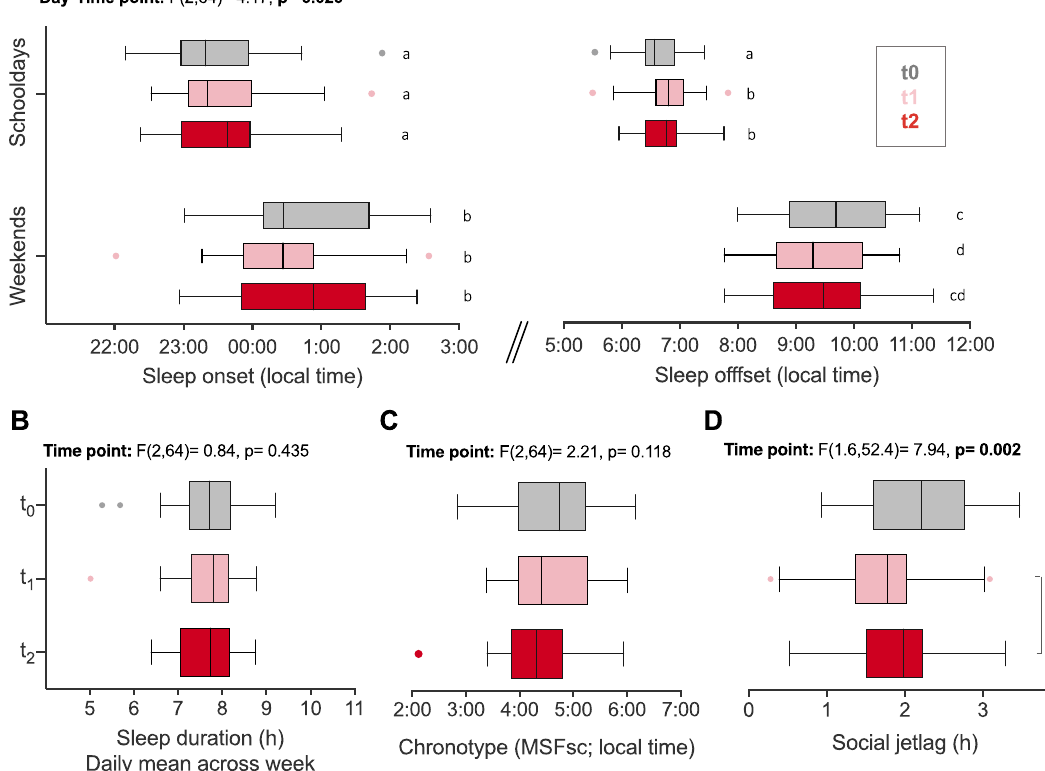
Figure 6. Comparison of sleep parameters across school start systems. Sleep parameters from the longitudinal cohort (n = 33) comparing the conventional start system at baseline (t0, grey) with the flexible system during t1 (light red) and t2 (dark red). ( A ) Average sleep onset and offset on schooldays and weekends. Results of two-way repeated measures ANOVAs with the factors day (schooldays/weekends) and time point (t0/t1/t2) are provided. Given the significant interaction effect, main effects are not reported. Letters indicate results of post-hoc tests on simple contrasts, with data marked by different letters demonstrating significant differences. ( B ) Average daily sleep duration across the week (weighted for 5 schooldays and 2 weekend days), ( C ) average chronotype, ( D ) average social jetlag. Results of one-way repeated measures ANOVAs across time points are presented above each graph. Brackets indicate statistically significant post-hoc comparisons. All boxplots are Tukey boxplots. See main text and Supplementary Tab. S3 for detailed effect sizes. *p < 0.05, **p < 0.01, ***p <